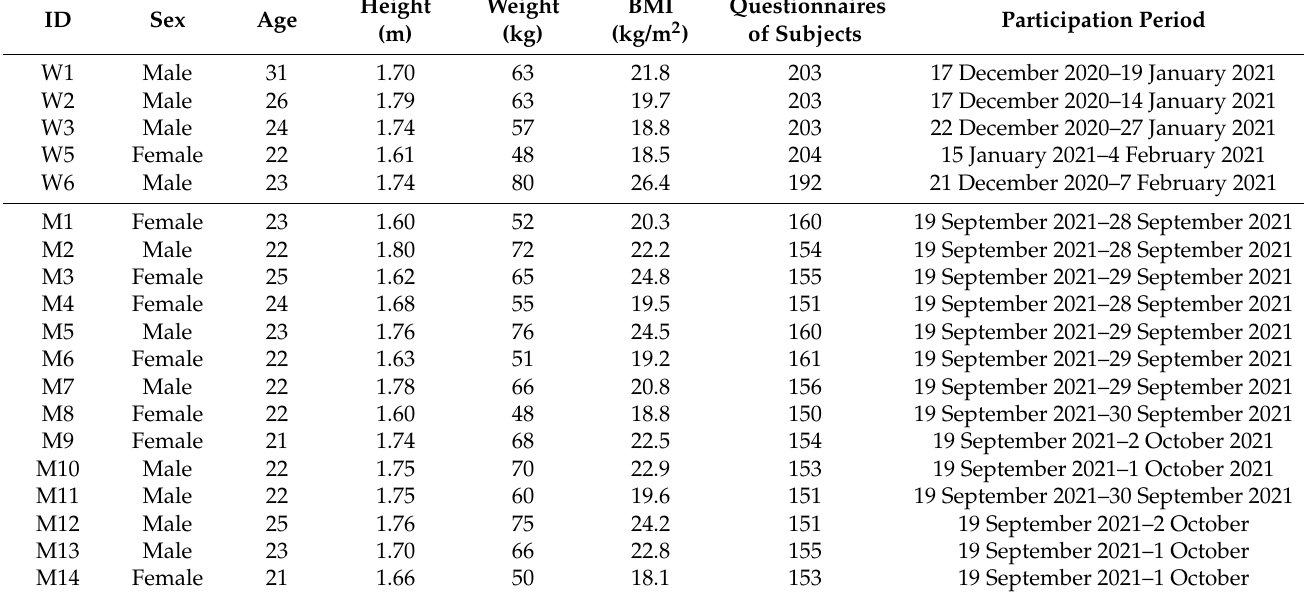
Table 1. The anthropometrics of the subjects in the